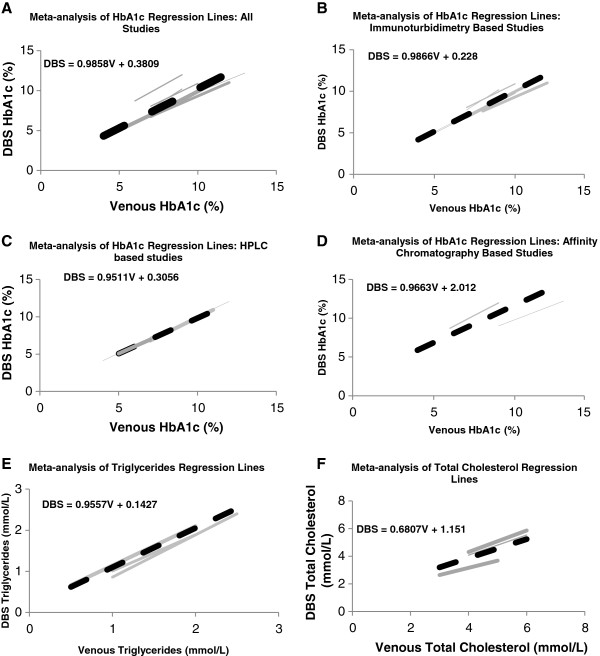
Individual (solid) and summary (dotted) regression lines showing the associations between results for analyses based upon dried blood spot (DBS) compared to venous (V) samples for haemoglobin A1c (HbA1c) analysed by any method (2A), HbA1c analysed by specific methods (2B to 2D), triglycerides (2E) and total cholesterol (2E). - Thickness of line increases with sample size. Line length was defined as ±1 standard deviation (SD) of the study (or overall) mean. Where the mean or SD of a study was not available the average for that analysis was used.